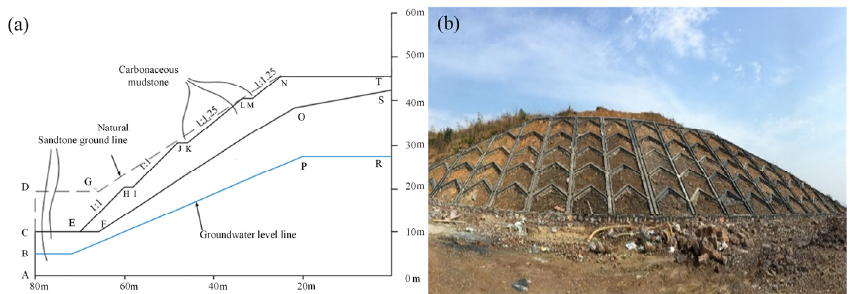
Figure 6. Basic information on the carbonaceous mudstone slope: ( a ) sketch; ( b ) photo.